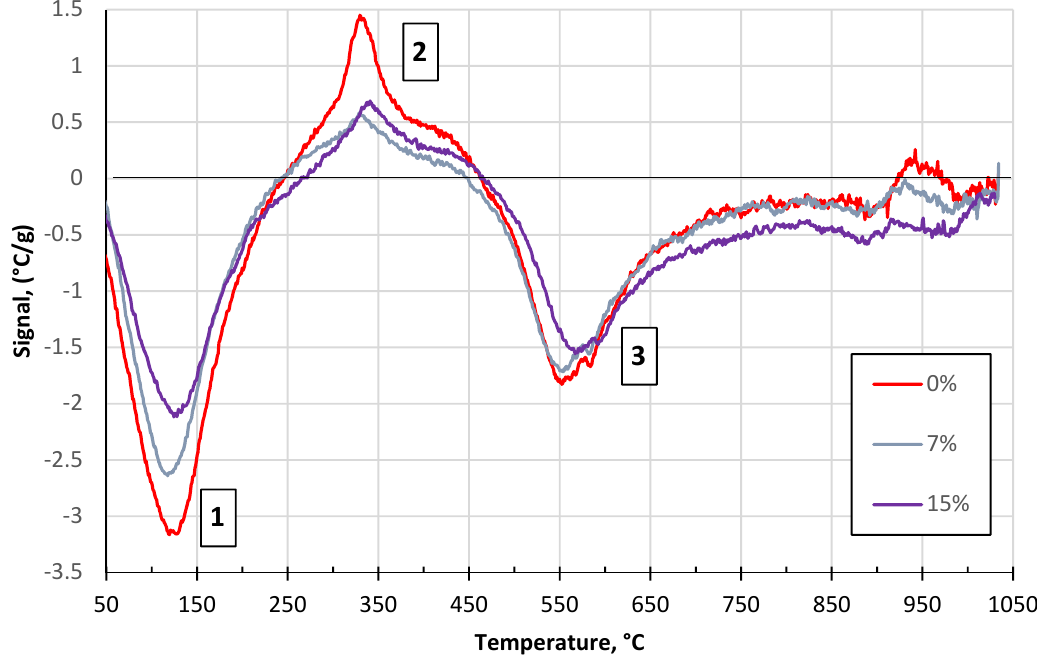
Figure 2. Differential thermal analysis (DTA) results of the tested clay-glass ceramic materials in the temperature range from 20 up to 1100 °C. The content of glass in wt% is in the legend.